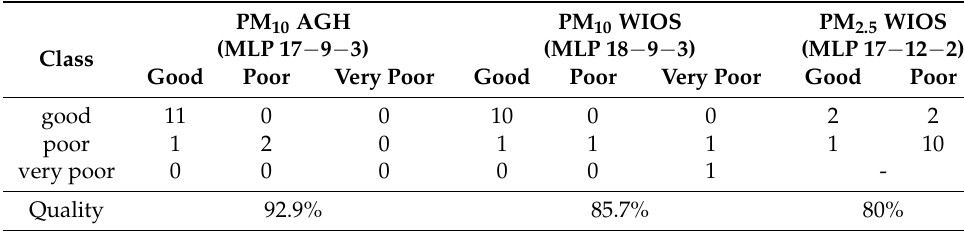
Table 3. Neural networks’ confusion matrices for the testing